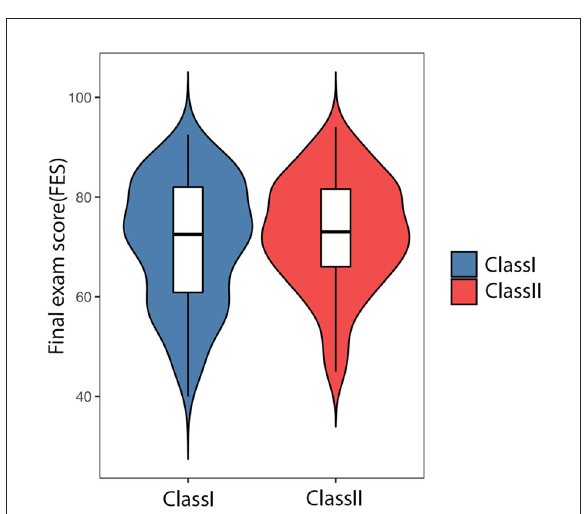
FIGURE3 The final exam score of traditional didactic lecture (TDL) and TBL education. Class I using TDL and Class II using